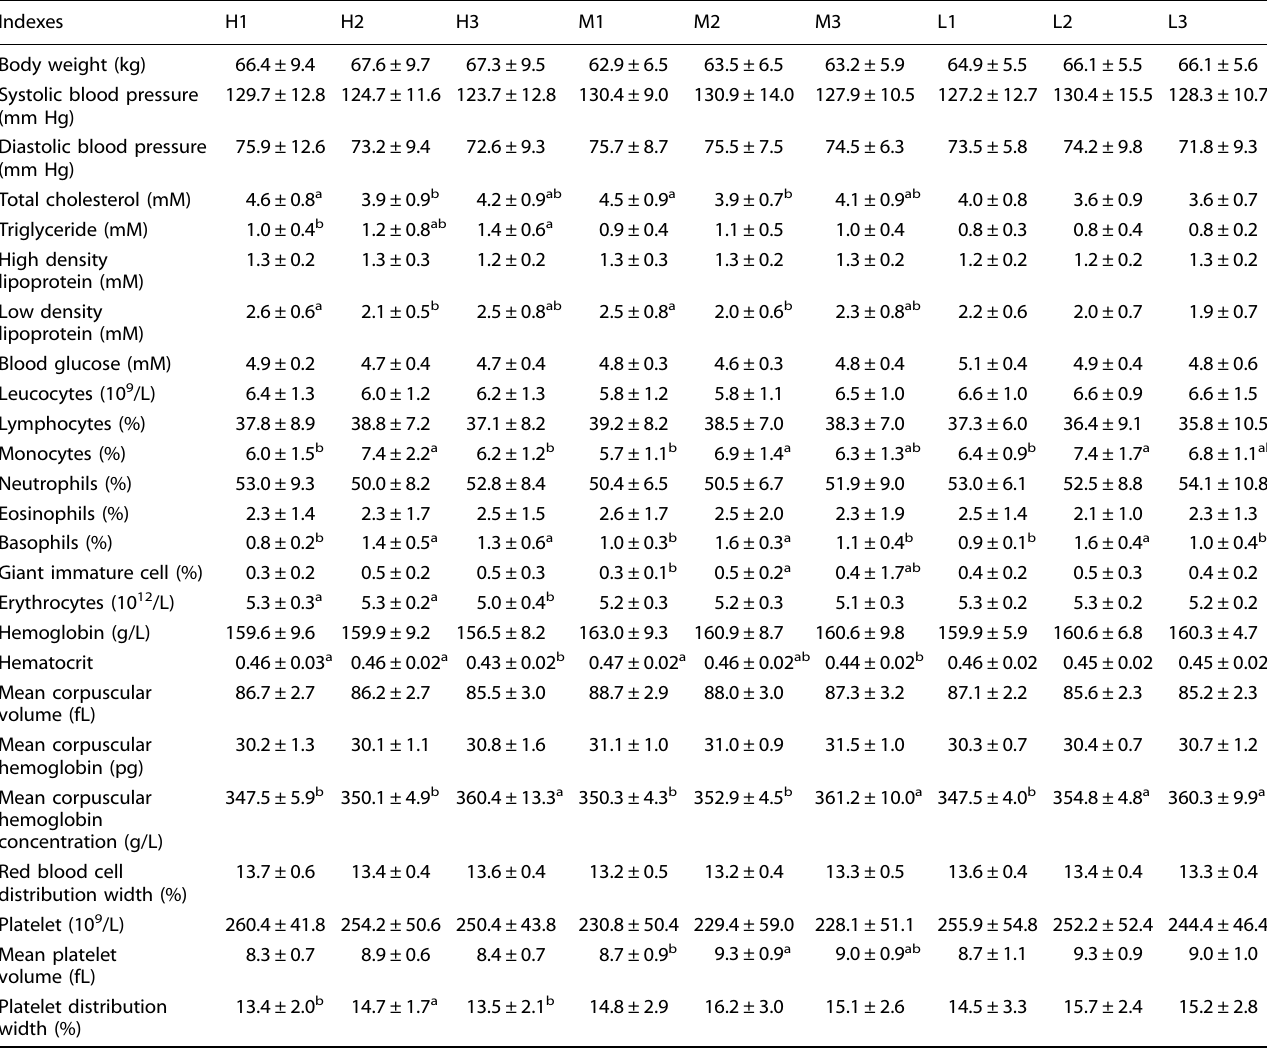
Table 1. Changes in the body weight and blood indexes induced by meat-based